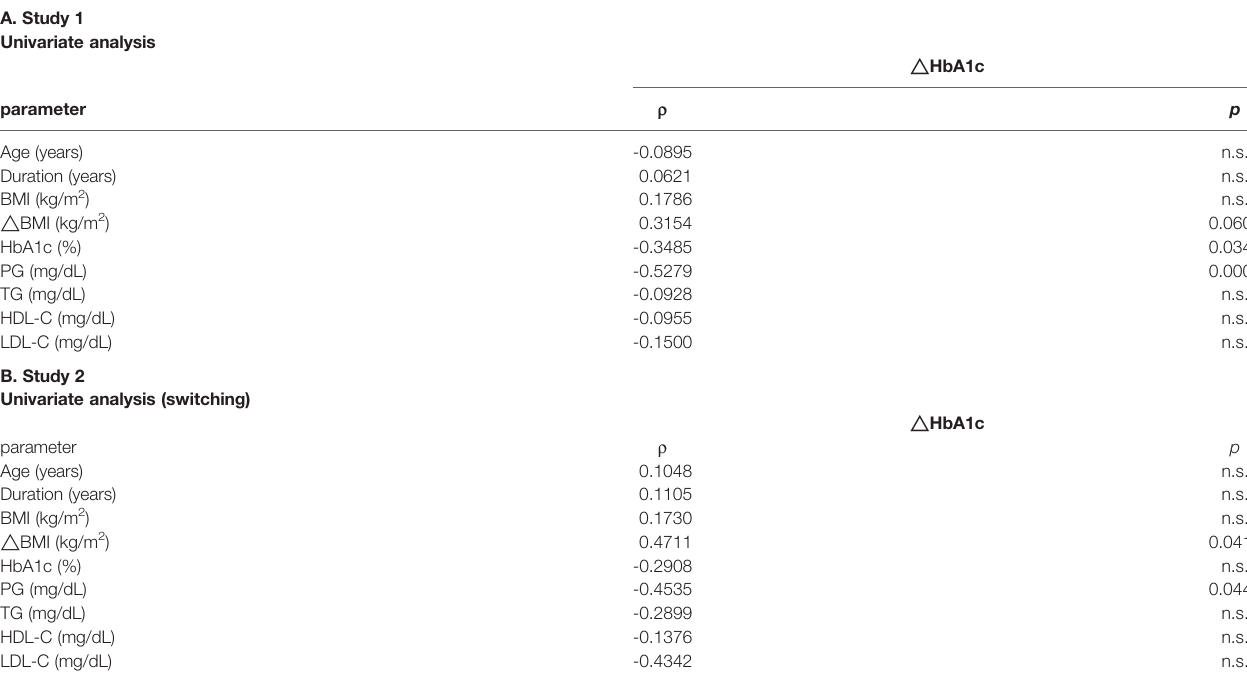
TABLE 3 | Univariate analysis evaluating the association between D HbA1c (6 months - baseline) and various clinical parameters at baseline.